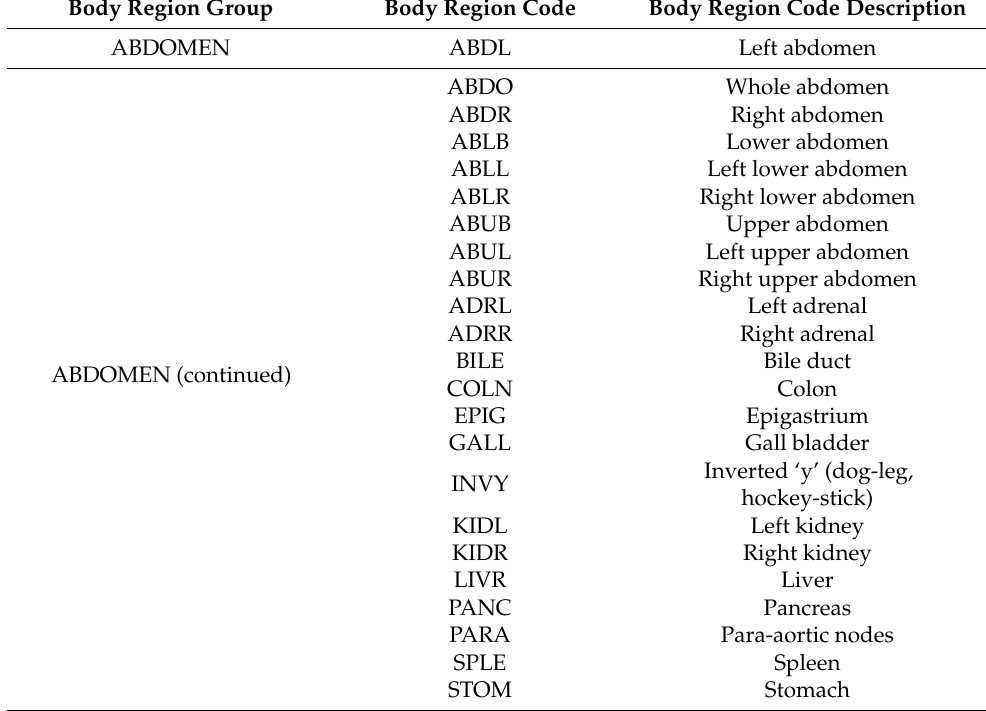
Table A6. Body regions and codes for receiving radiation that indicated a second breast cancer